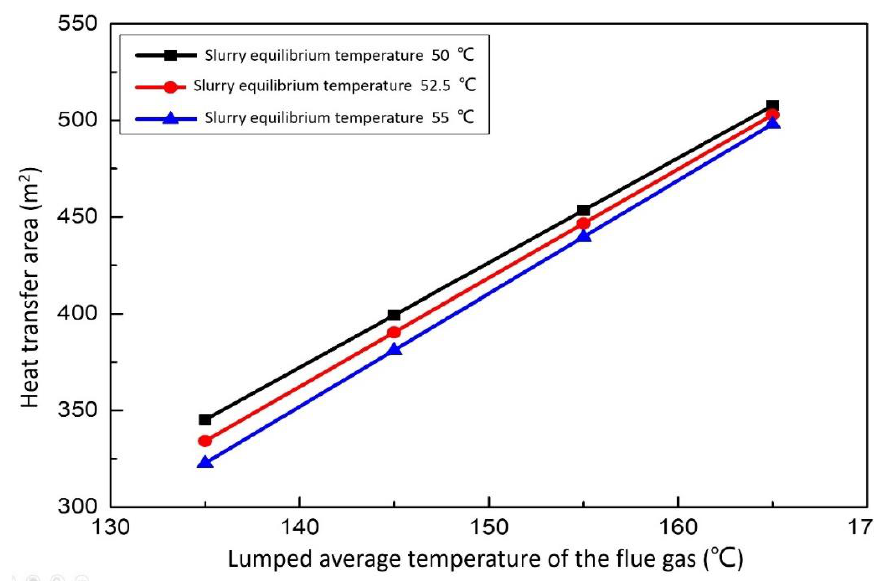
Figure 12. Effect of the lumped average temperature of the flue gas on the heat transfer area.